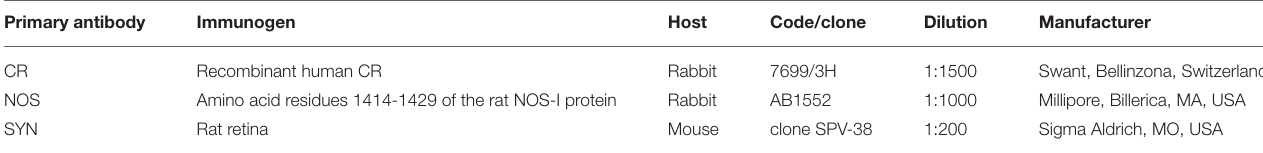
TABLE 1 | List of primary antibodies. Primary antibody